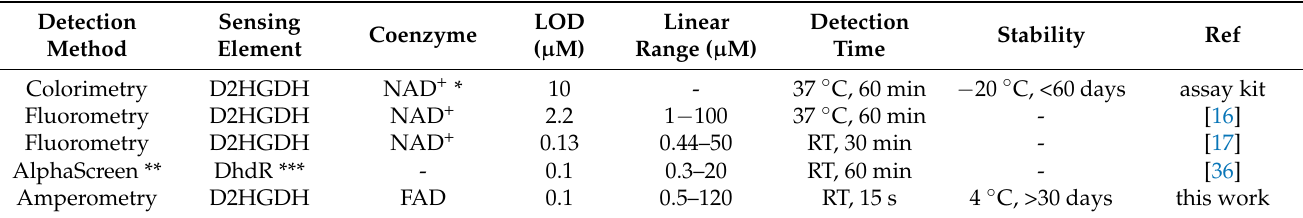
Table 1. Comparison of the constructed D2HG biosensor with other